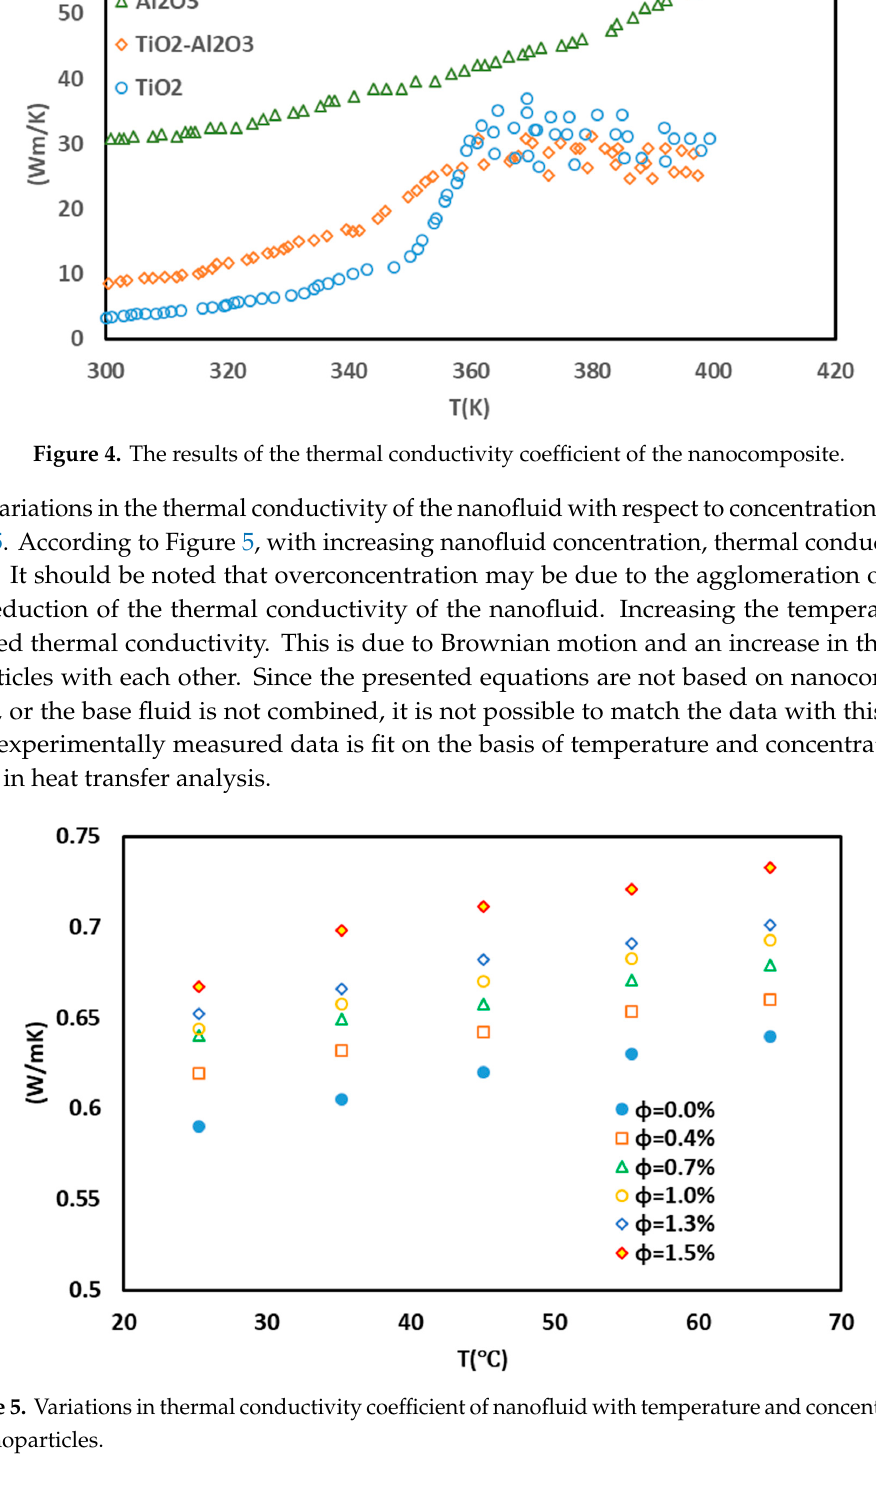
Figure 3. The results of the specific heat capacity of the nanocomposite.